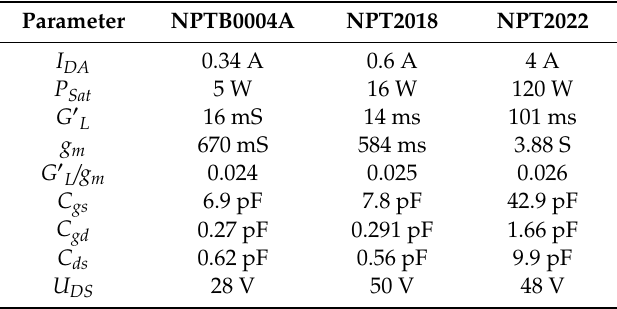
Table 1. Selected parameters for three di ff erent GaN HEMTs calculated at the average current for corresponding to P sat .